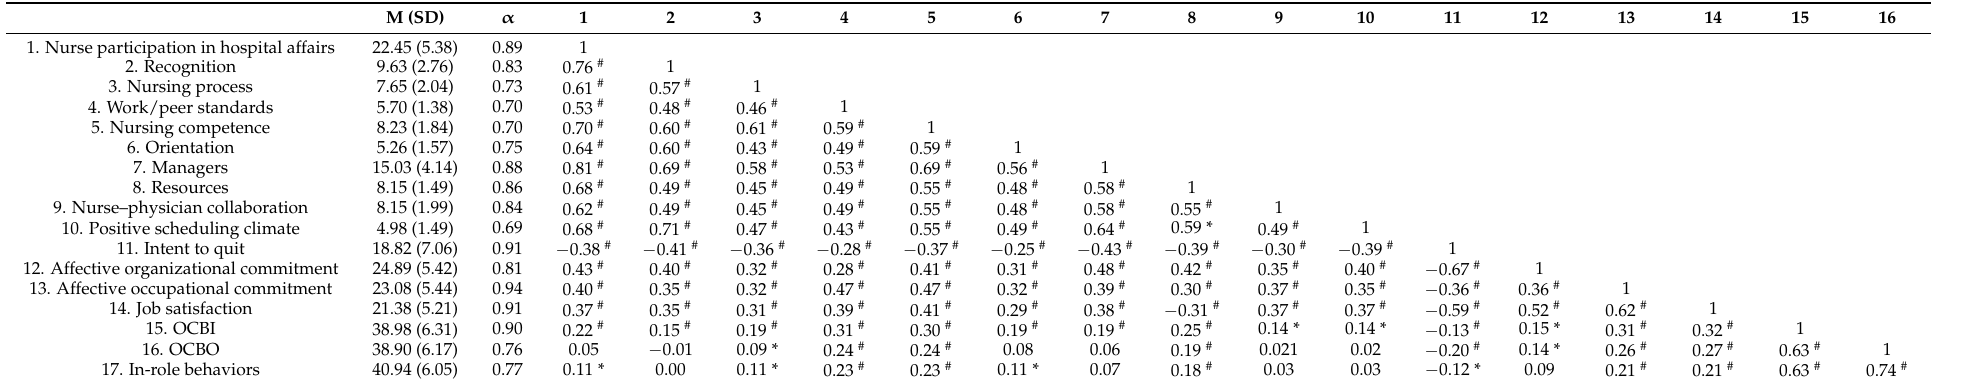
Table 3. Mean (standard deviation), reliability coefficients, and correlations of the revised model’s scales and the outcome variables.